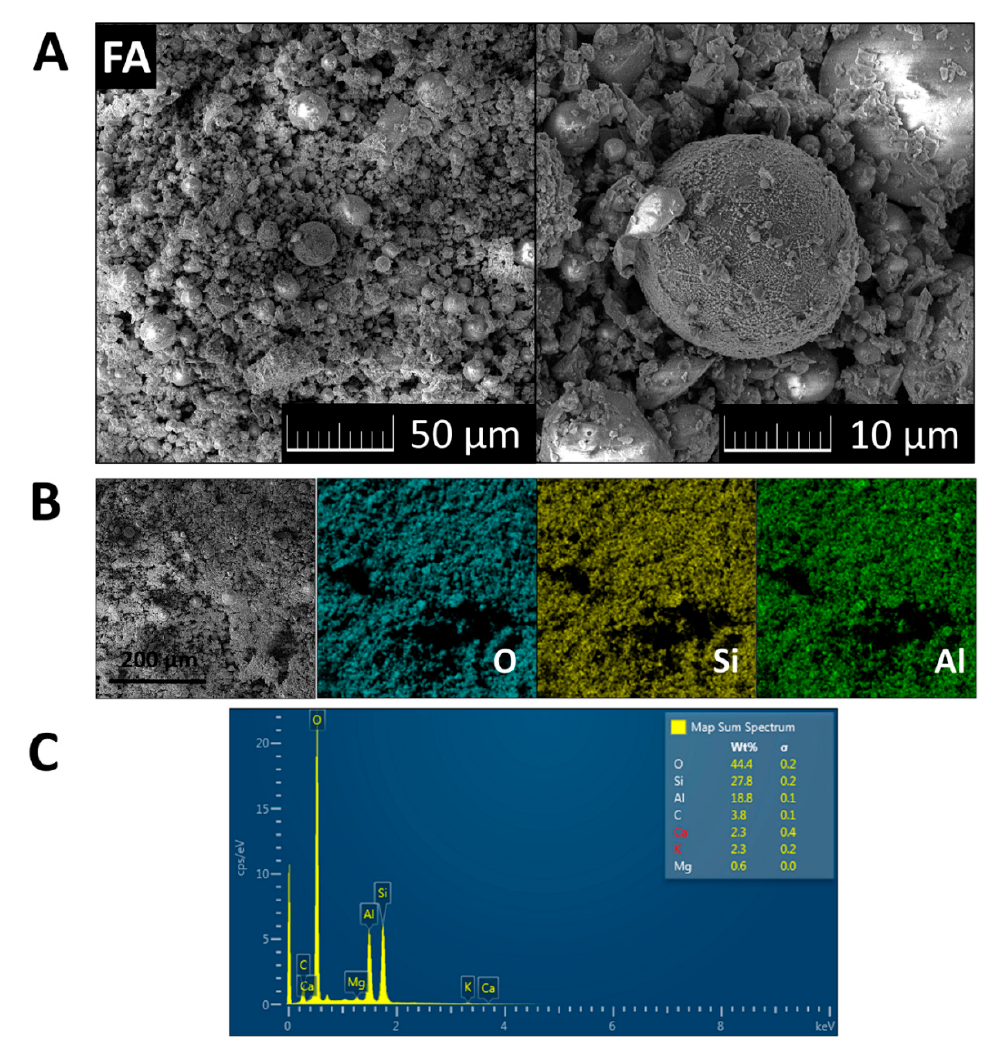
Figure 2. ( A ) SEM micrographs of FA; ( B ) EDS elemental maps of major elements; ( C ) and EDS spectrum.